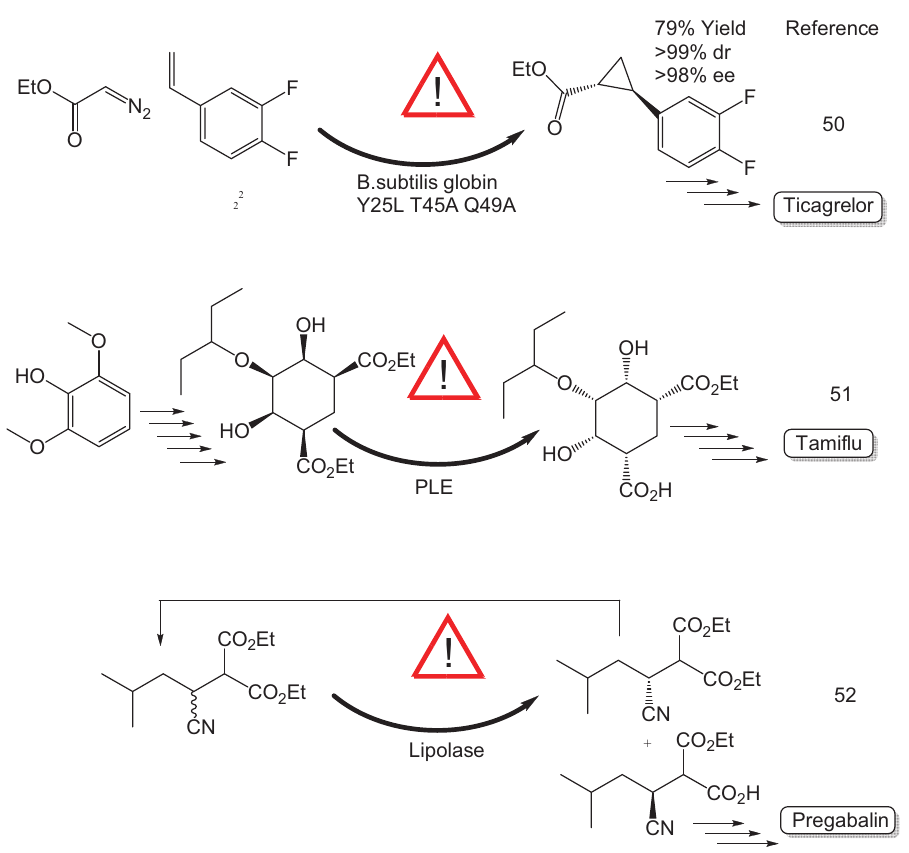
Fig. 4 – Debottlenecking single biocatalytic reactions in synthetic